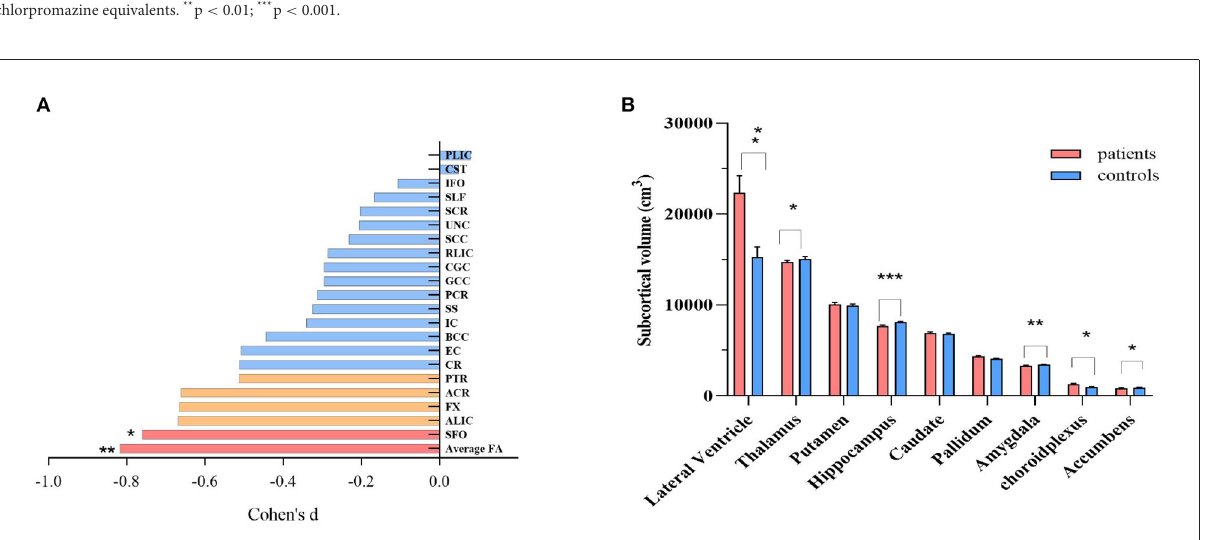
FIGURE1 Comparison of regional white matter FA (A) , and subcortical gray matter volume (B) between schizophrenia patients and healthy controls. ANCOVA was conducted in our study, with age, sex and intracranial volume as covariates. For white matter FA, nominal correlations after multiple comparison ( p > 0.05/21 = 0.002) were drawn in orange. ACR, anterior corona radiata; ALIC, anterior limb of internal capsule; BCC, body of corpus callosum; CGC, cingulum; CR, corona radiata; CST, cortico-spinal tract; EC, external capsule; FX, fornix; GCC, genu of